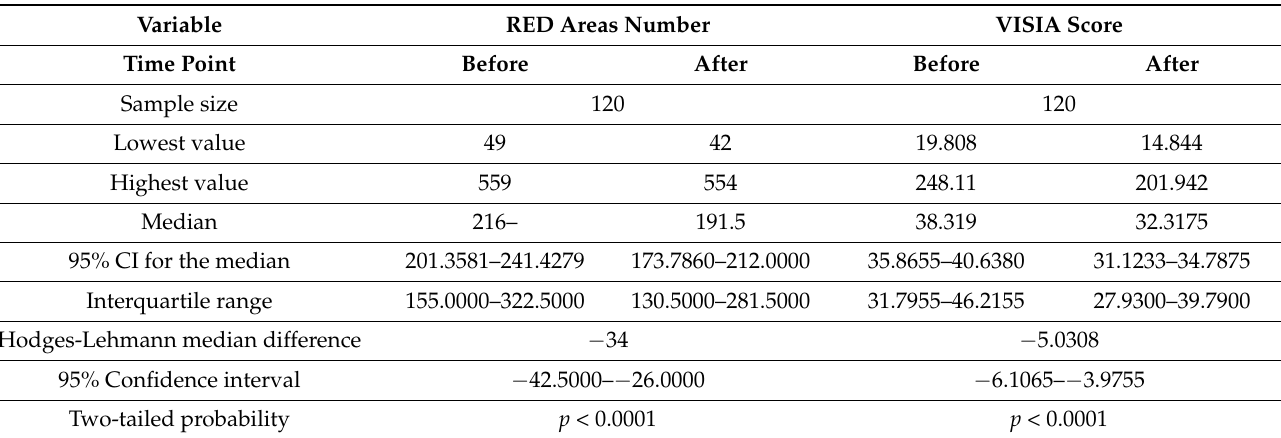
Table 1. Comparison of the number of red areas and the VISIA score of the assessment before and after the treatment in the whole study